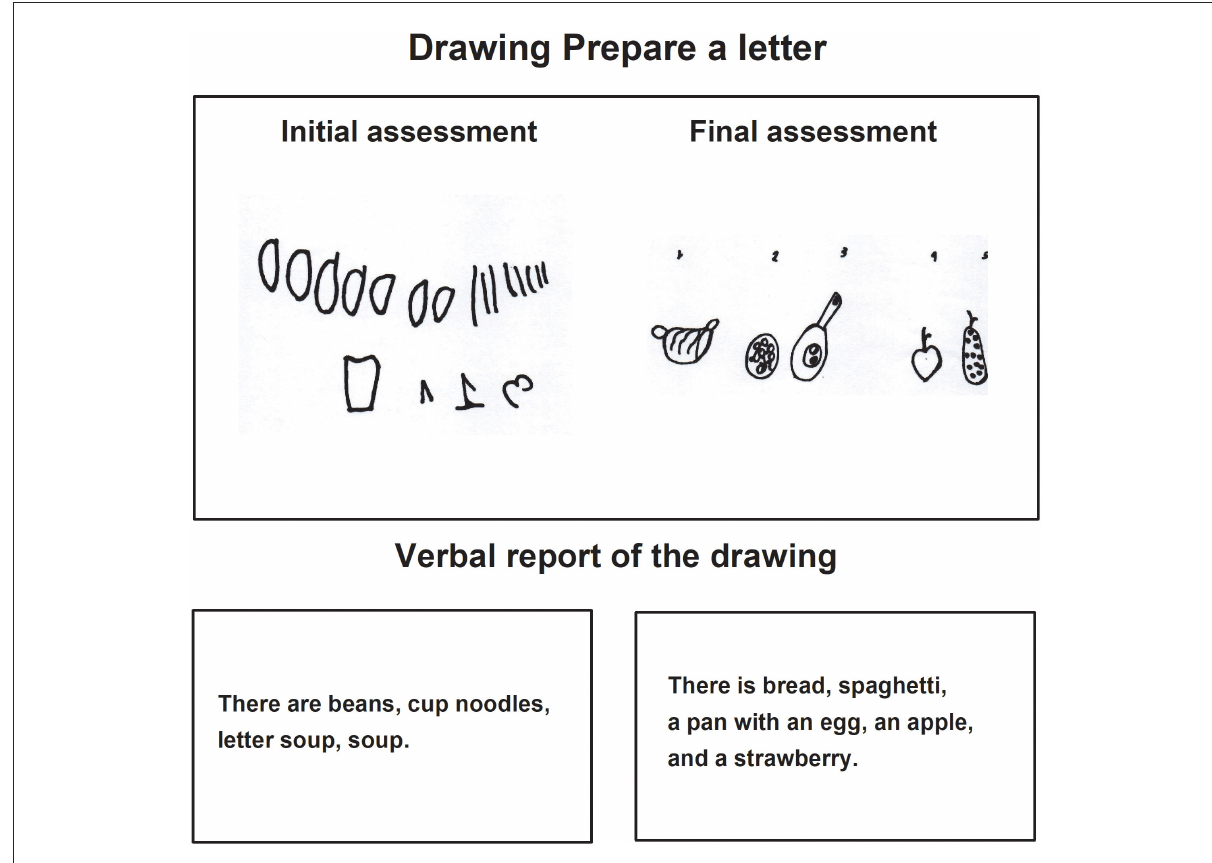
FIGURE3 Child C drawing of the task prepare a letter during the initial and final